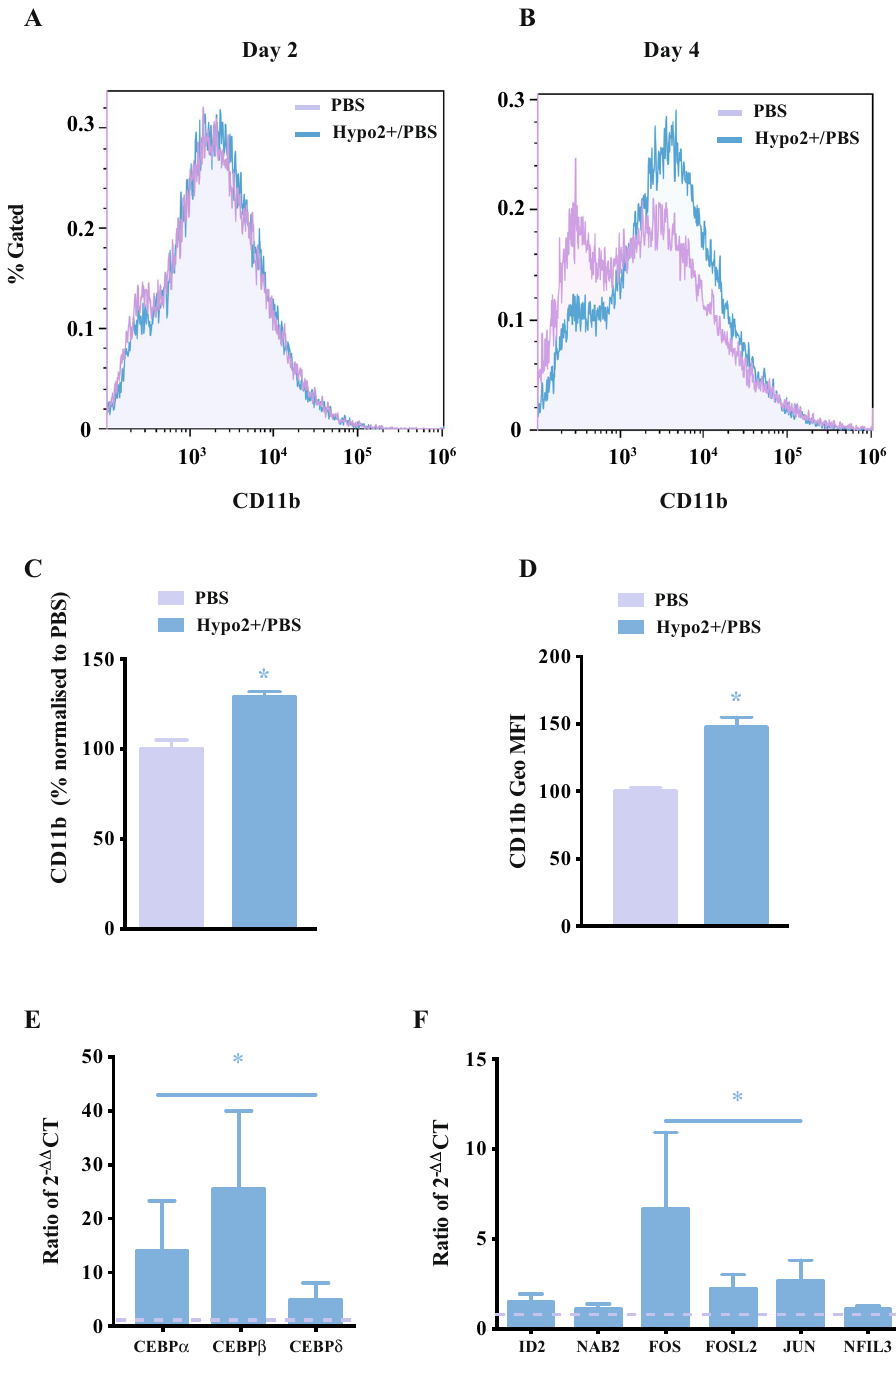
Figure 6. Effect of hyposmotic modulation in cell fate transdifferentiation. ( A , B ) CD11b expression by the HAFTL C10 cell line during the transdifferentiation. Although the images provided are from a single experiment, the same experiment was done at least two more times with similar results. ( C ) CD11b expression (% of cells expressing CD11b relative to PBS-control) by the HAFTL C10 cell line at day 4 of transdifferentiation. ( D ) CD11b expression (Geo MFI, geometric mean fluorescence intensity) by the HAFTL C10 cell line at day 4 of transdifferentiation. ( E ) Transcriptional characterization of CEBP-family genes assessed at day 4 of transdifferentiation in HAFTL C10 cell line by qRT-PCR (ratio between the expression levels (2 − ΔΔ CT) in the two transdifferentiation conditions) (ANOVA test used). ( F ) Gene expression of CEBP-related transcription factors assessed at day 4 of transdifferentiation in HAFTL C10 cell line by qRT-PCR (ratio between the expression levels (2 −ΔΔ CT) in the two transdifferentiation conditions) (ANOVA test used). The different osmotic modulation protocols are described in the legend of each graph. The data presented corresponds to the mean value ± SEM (n ≥ 3) and the changes are statistically significant at the time points highlighted in the graphs ( * p value <